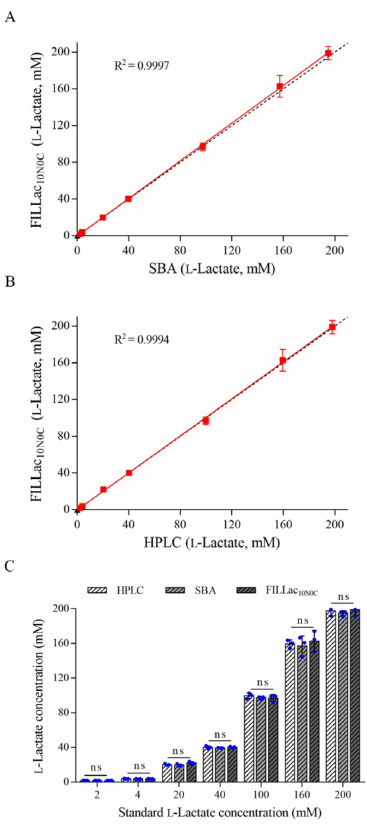
Figure 4. Performance of FILLac 10N0C in L -lactate quantitation. ( A ) Comparison of the quantitative analysis of L -lactate by using HPLC and FILLac 10N0C . Concentrations detected by HPLC were used as control ( x -axis). The black dashed line is a reference line with a slope of 1. ( B ) Comparison of the quantitative analysis of L -lactate by using SBA-40D bioanalyzer and FILLac 10N0C . Concentrations detected by SBA-40D bioanalyzer were used as control ( x -axis). The black dashed line is a reference line with a slope of 1. ( C ) Quantification of L -lactate by HPLC, SBA-40D bioanalyzer and FILLac 10N0C . Standard concentrations of L -lactate are 2, 4, 20, 40, 100, 160, and 200 mM. All data shown are mean ± s.d. (n = 3 independent experiments). The significance of the data was analyzed by a two-tailed, unpaired t -test; ns, no significant difference ( p ≥